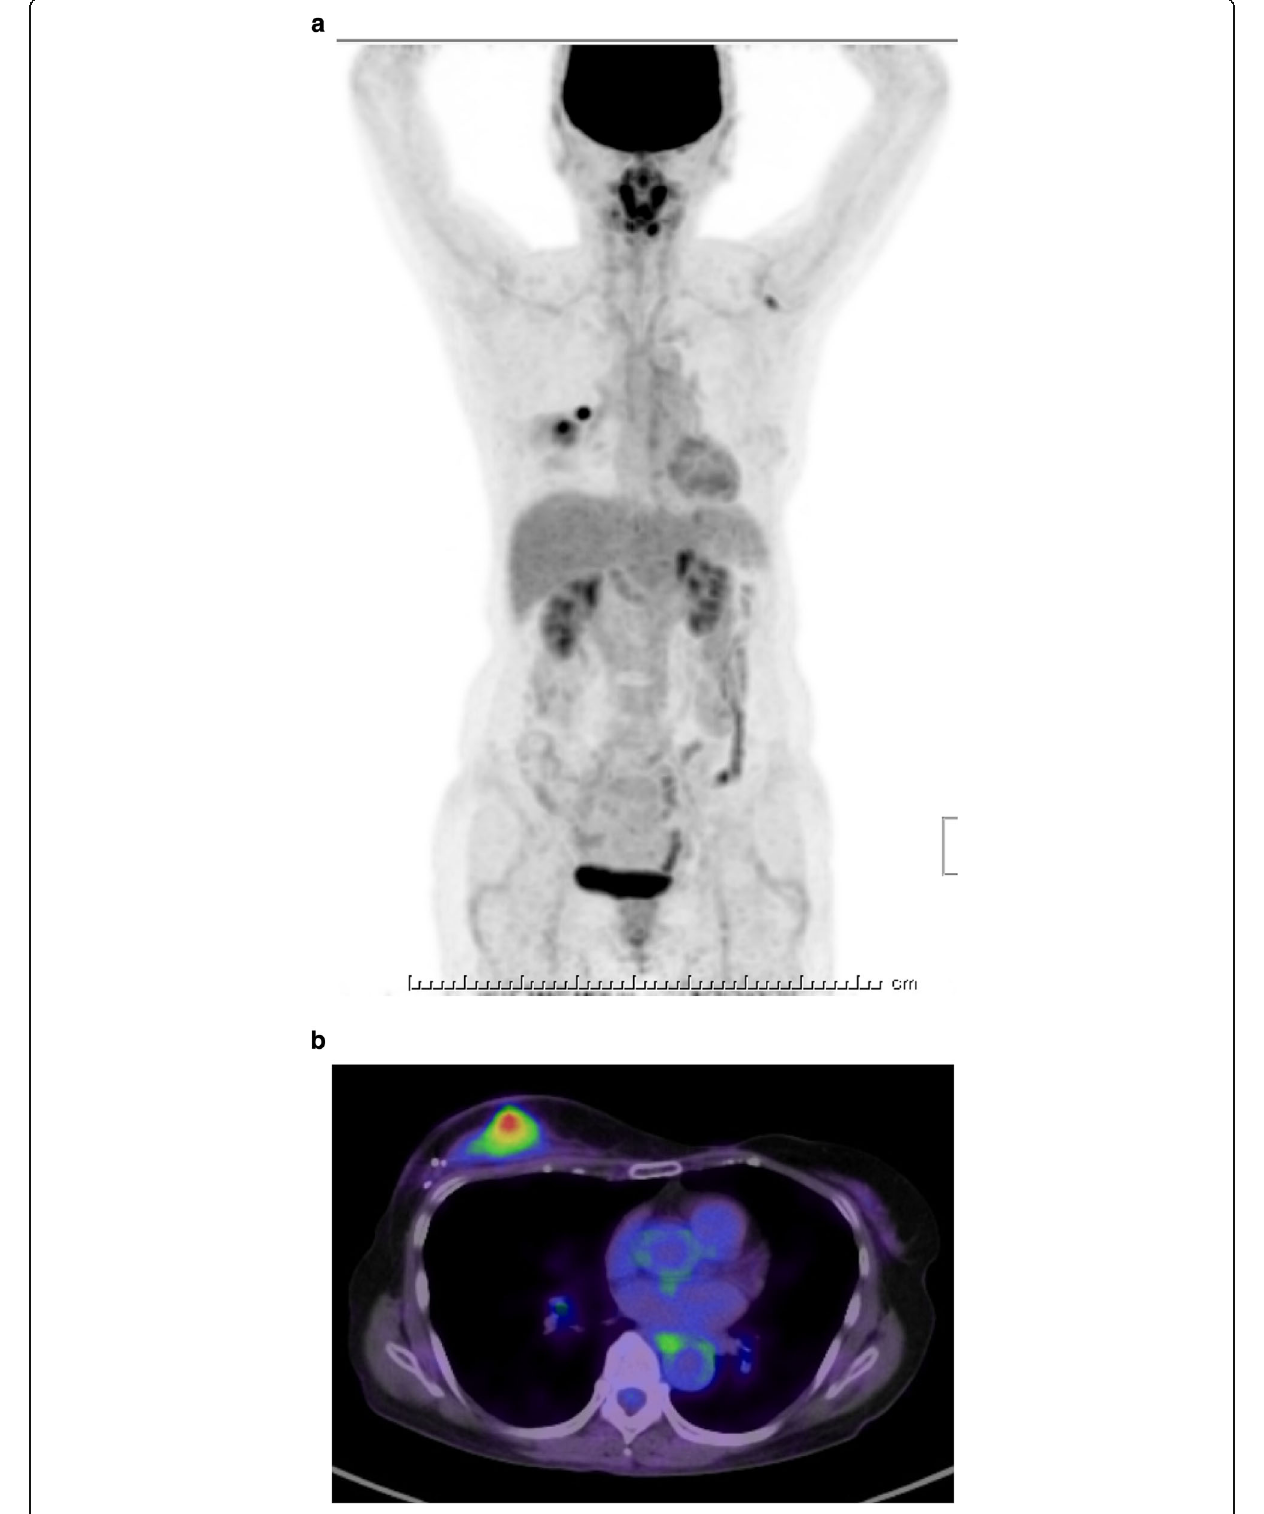
Fig. 3 a PET/CT before the surgery showed no metastatic disease. b PET/CT showed accumulation in the